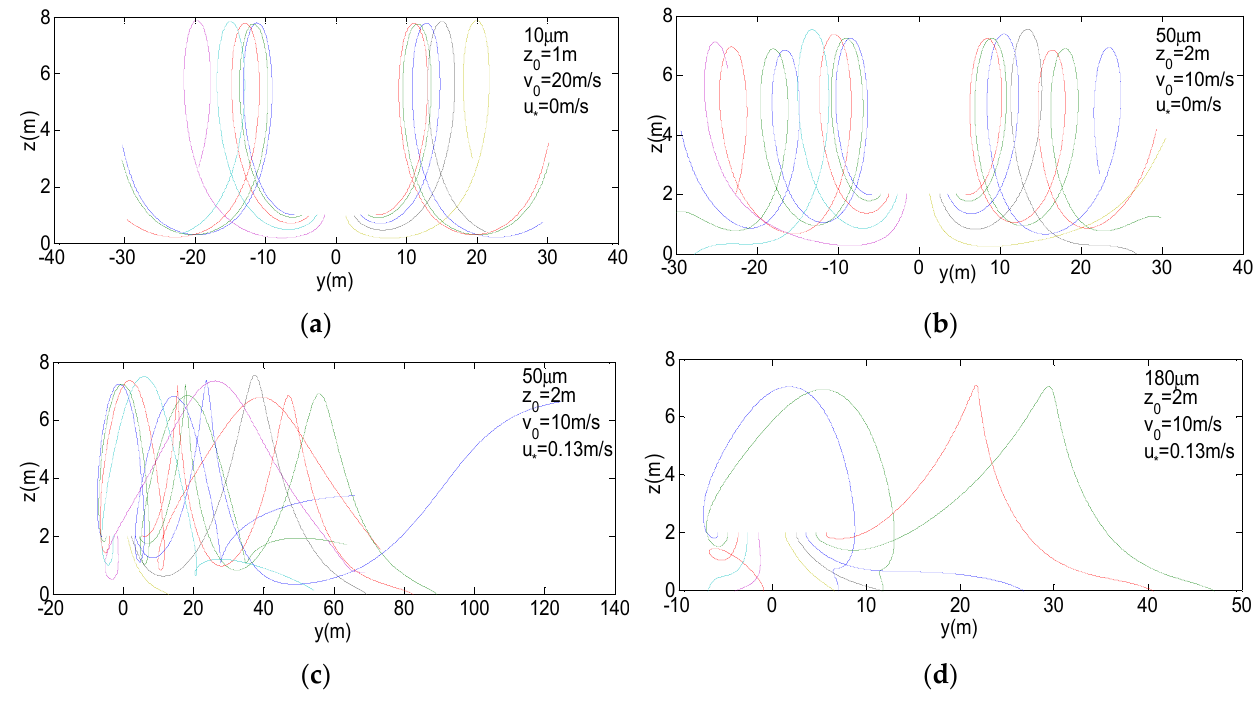
Figure 23. Droplet trajectories under different conditions: ( a ) size 10 µ m, release height z 0 = 1 m, outlet velocity v 0 = 20 m/s, friction velocity u * = 0 m/s; ( b ) size 50 µ m, release height z 0 = 2 m, outlet velocity v 0 = 10 m/s, friction velocity u * = 0 m/s; ( c ) size 50 µ m, release height z 0 = 2 m, outlet velocity v 0 = 10 m/s, friction velocity u * = 0.13 m/s; ( d ) size 180 µ m, release height z 0 = 2 m, outlet velocity v 0 = 10 m/s, friction velocity u * = 0.13